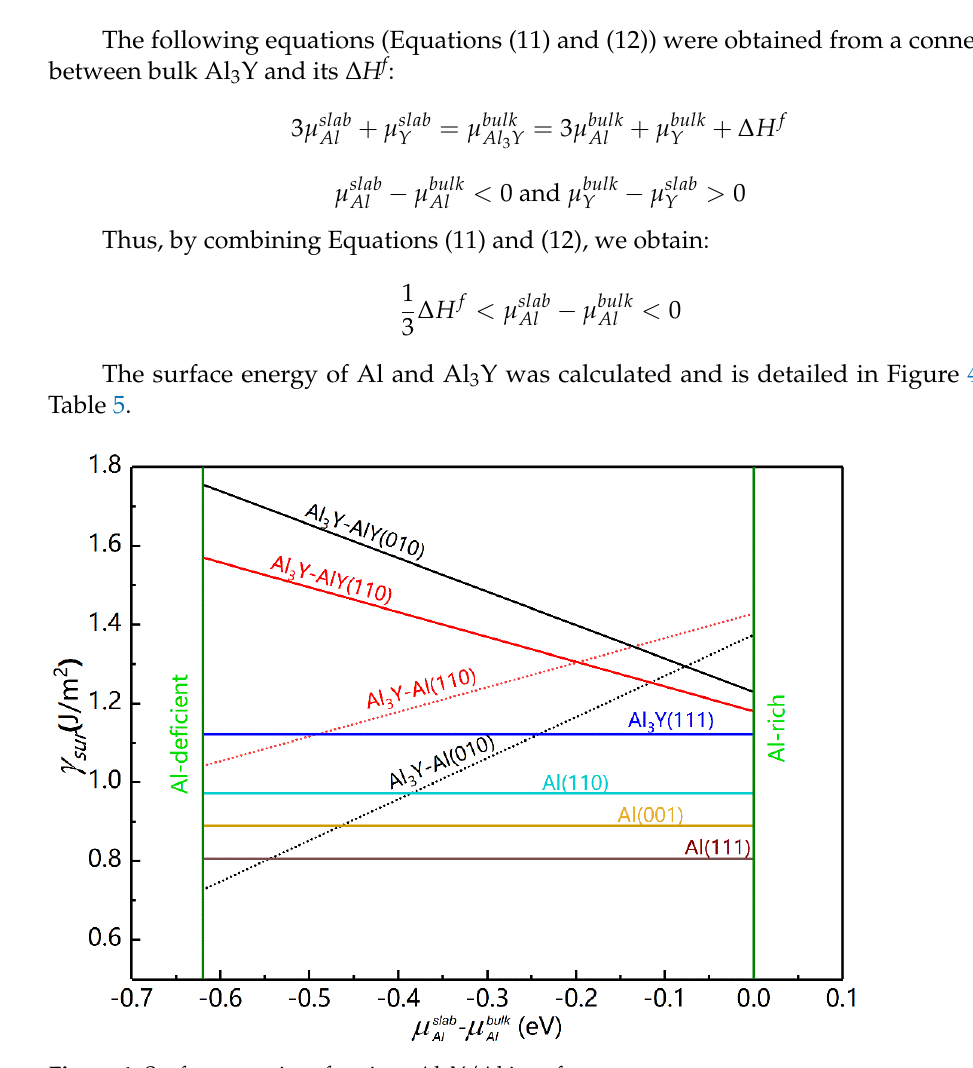
Figure 4. Surface energies of various Al 3 Y/Al interfaces. Table 5. Interfacial ( γ int ) energy obtained using Model 2 and calculated surface energies ( γ sur ) of Al and Al 3